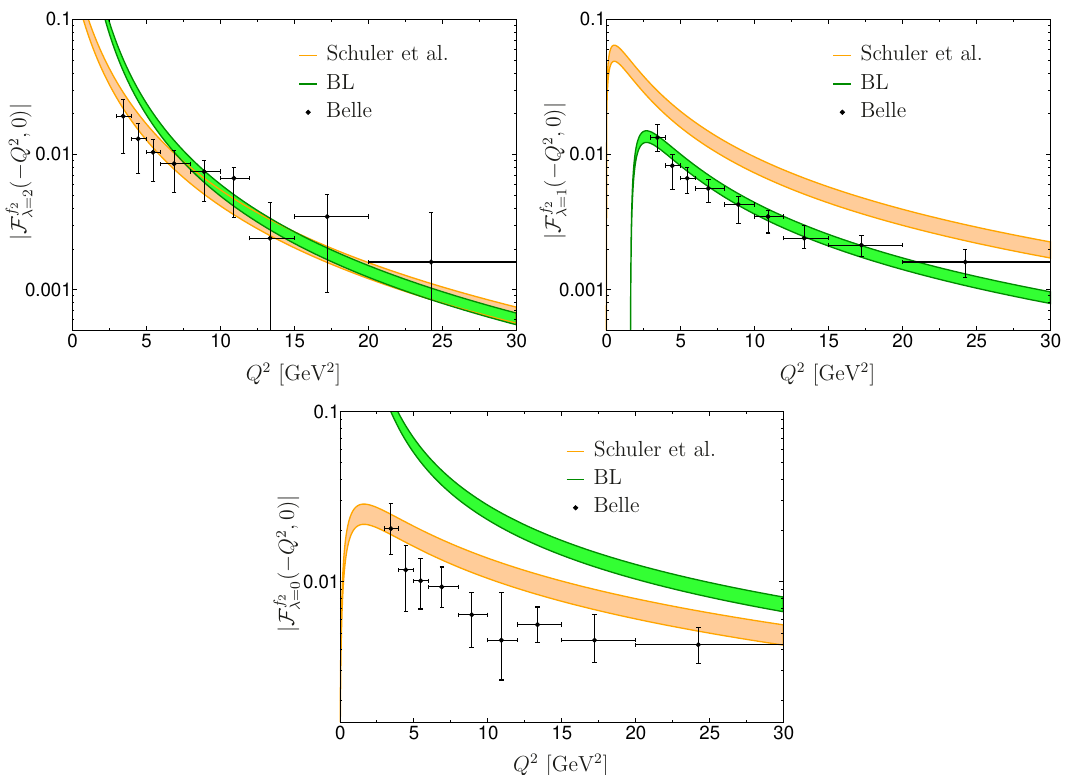
Figure 4 . Tensor TFFs for helicities (cid:21) = 2 ; 1 ; 0 for the f 2 (1270), in comparison to the Belle data [57]. The orange band refers to the quark model from [82], see (3.47), and the green band to the asymptotic BL result (4.18), with e(cid:11)ective decay constant from (4.20). For the quark- model normalization uncertainties are propagated from (cid:0) (cid:13)(cid:13) [4], assuming that this also covers the T contribution from (0 ; 0) in 2 F